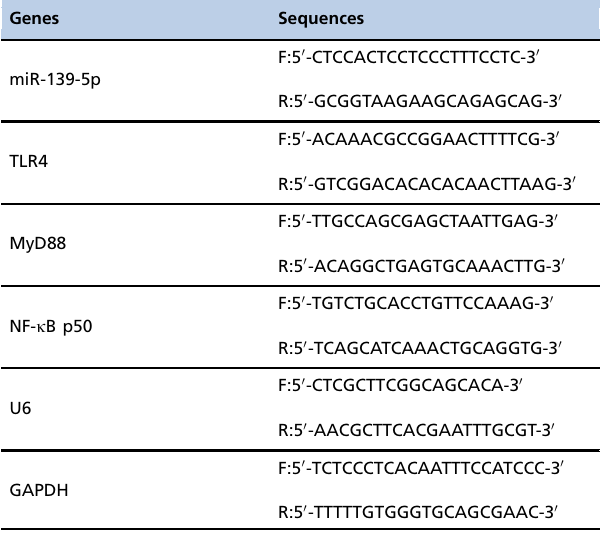
Table 1 - qRT-PCR primer sequences.